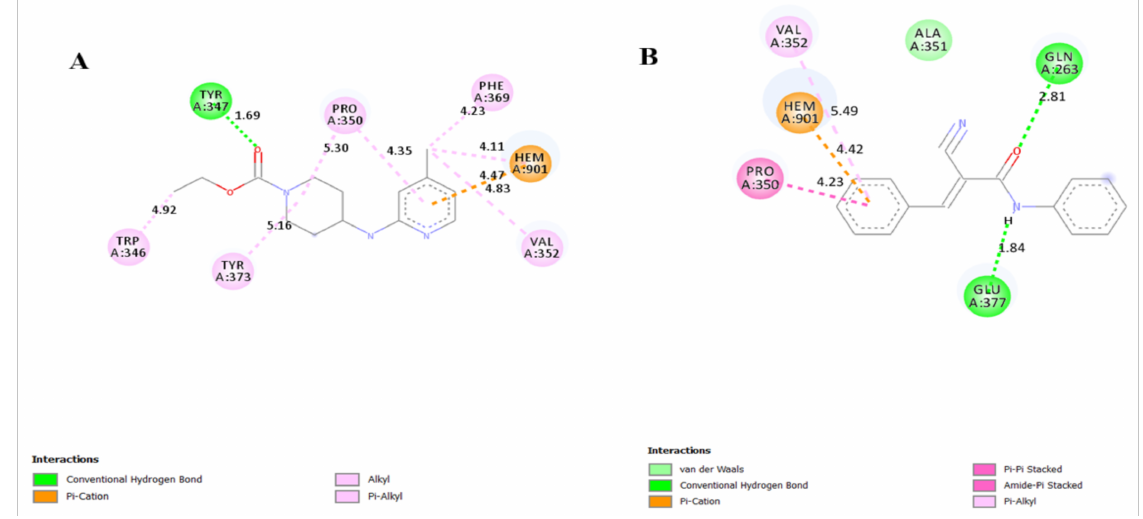
Figure 7. Ligand AR-C95791 ( A ) and JMPR-01 ( B ) in iNOS target (PDB ID: 3E7G). Delineation of the affinity of JMPR-01 with PDE4 (an isoform that has specific hy- drolyzing capacity on cAMP—a second messenger with modulatory action on effector cells in the pathogenesis of inflammation) was also tested [52]. PDE4 as an inhibited phar- macological target is correlated with a consequent intracellular accumulation of cAMP, which can directly activate protein kinase A (PKA) (responsible for phosphorylation of cAMP-responsive protein (CREB) and activating factor of transcription (ATF-1)), leading to increased synthesis of anti-inflammatory cytokines